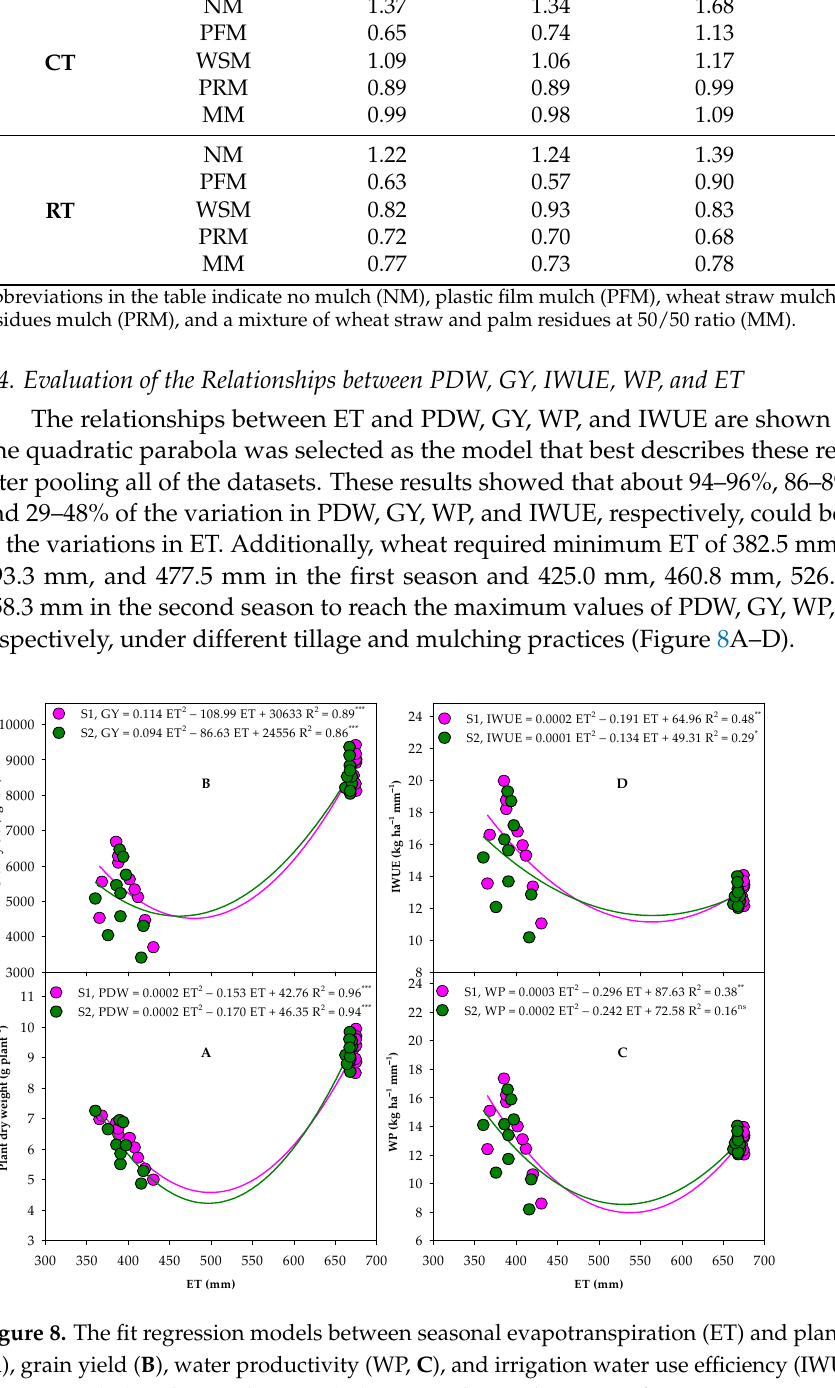
Table 4. Yield response factor (ky) shown as the relationship between the relative decrease in plant dry weight (Ky PDW ) and grain yield (Ky GY ) and the corresponding relative decrease in evapotranspiration for different mulching treatments under conventional tillage (CT) and reduced tillage (RT) practices in the 0.50 ET treatment in two growing seasons. Ky PDW Ky GY Tillage Mulching